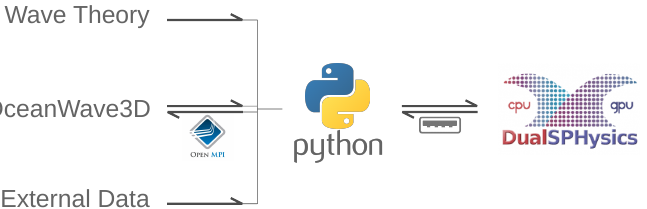
Figure 5. Coupling implementation scheme showing several options to generate and absorb waves within a two-way coupled model: wave theory solutions, the wave propagation model OceanWave3D or any external